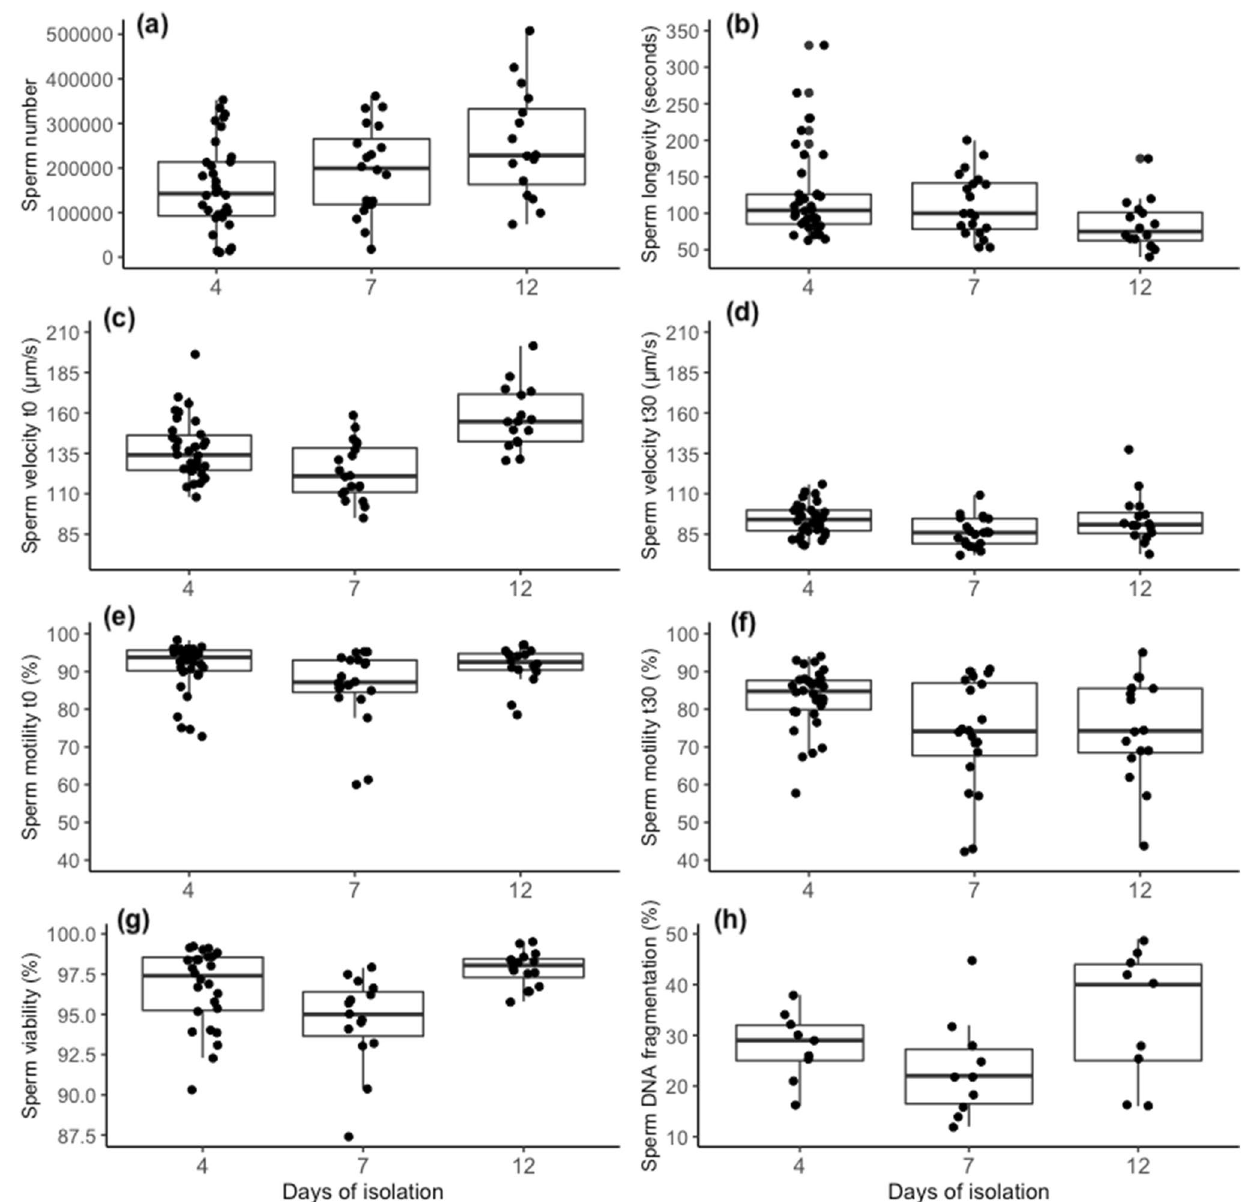
Figure 2. Effects of sperm storage duration on zebrafish sperm traits. Boxplots showing sperm traits in function of sperm storage duration (i.e. day of isolation): 4, 7, 12. Each dot represents a sample [panel ( a – f) 4 days: N = 34, 7 days: N = 20, 12 days: N = 16; panel ( g) 4 days: N = 26, 7 days: N = 15, 12 days: N = 16; panel ( h ) 4 days: N = 9, 7 days: N = 10, 12 days: N = 9). Note that for sperm DNA fragmentation, each dot represents a single male that has experienced one condition, while for the other sperm traits (panel a – g ) each male experienced two different experimental conditions (4–7 days and 4–12 days). Sperm motility ( e , f ), sperm viability ( g ), and sperm DNA fragmentation ( h ) are expressed in percentage for graphical